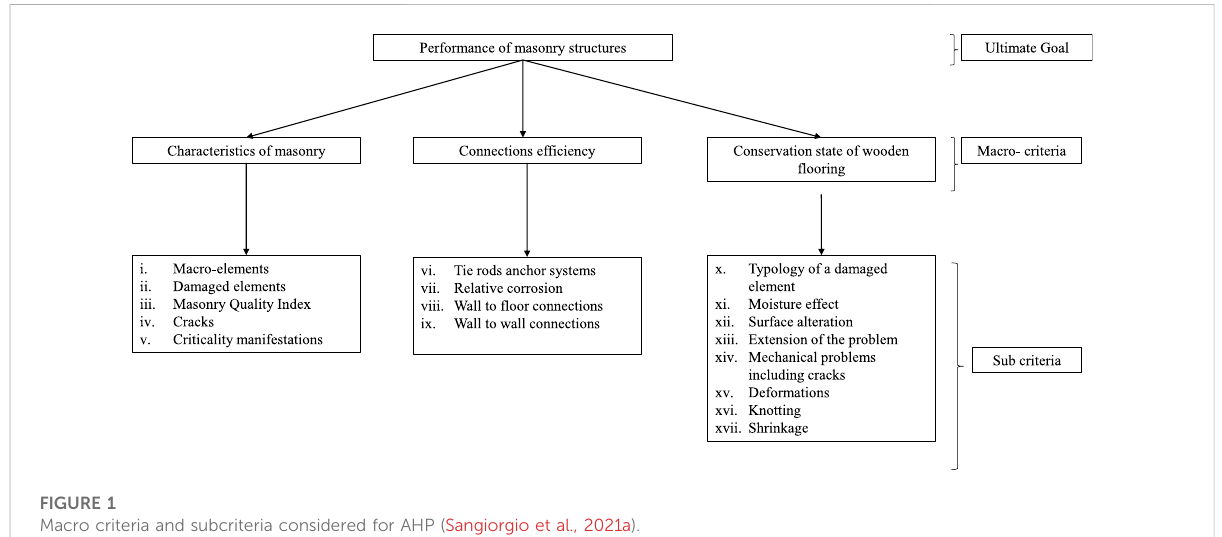
FIGURE 1 Macro criteria and subcriteria considered for AHP (Sangiorgio et al.,